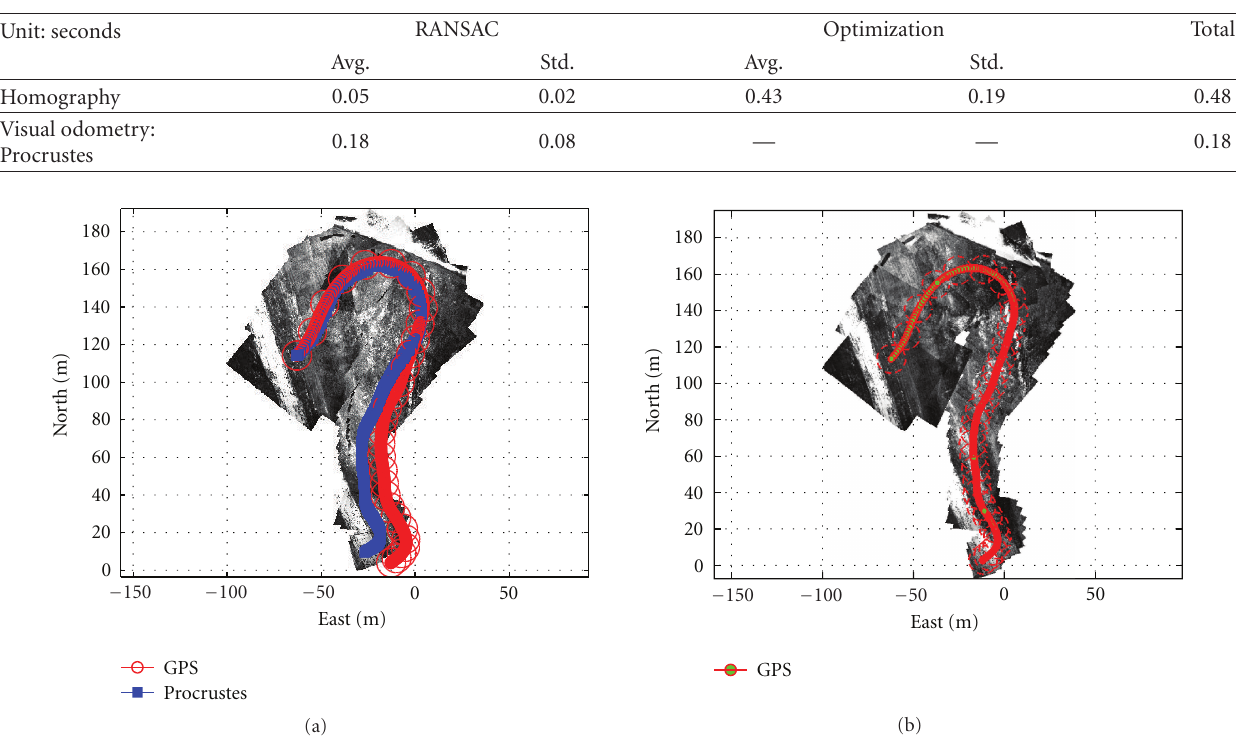
Table 3: Average execution times of visual odometry techniques, in seconds.